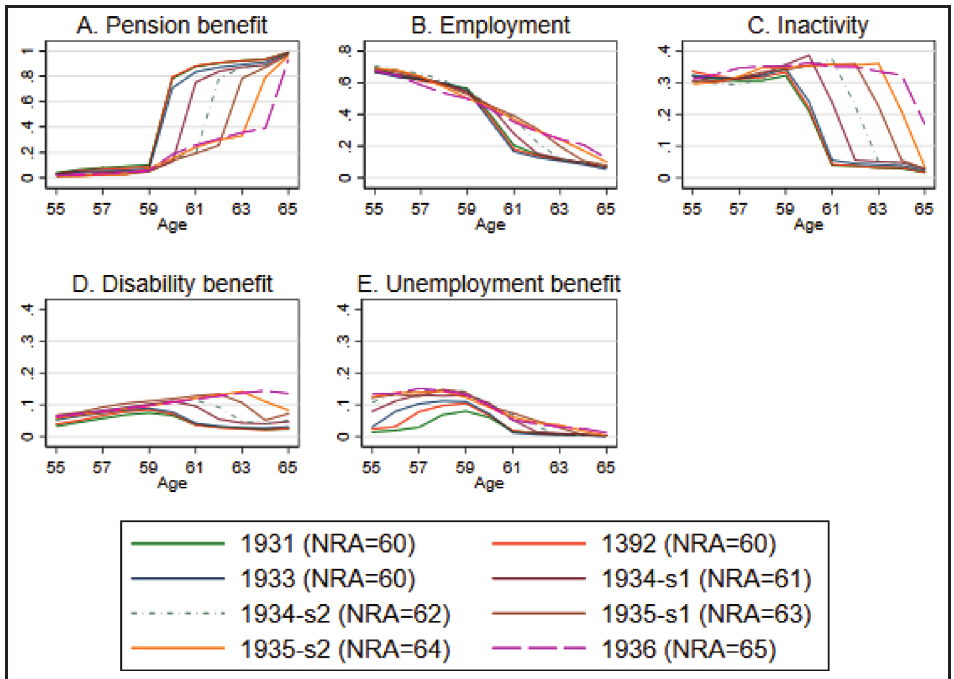
Figure 2 Labor Market Outcomes (%) by age and birth